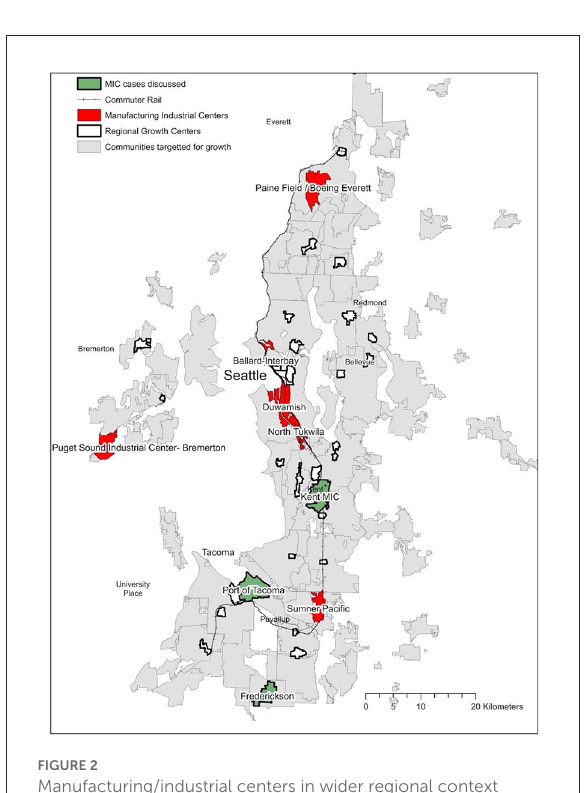
FIGURE2 Manufacturing/industrial centers in wider regional context (Source: authors’ rendering from PSRC.org GiS